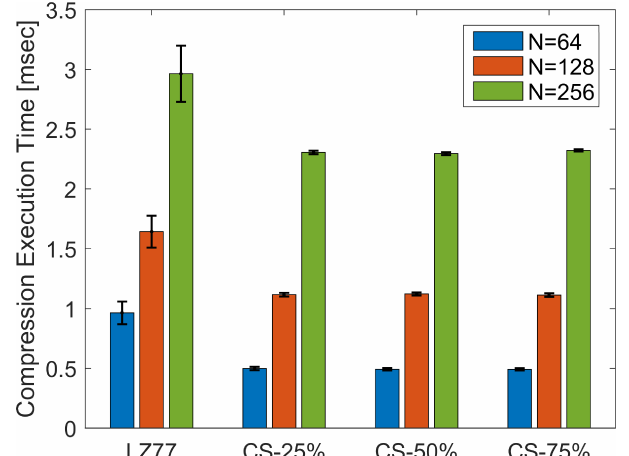
Figure 9. Average and standard deviation of CET, over the total number of pressure blocks, for different compression